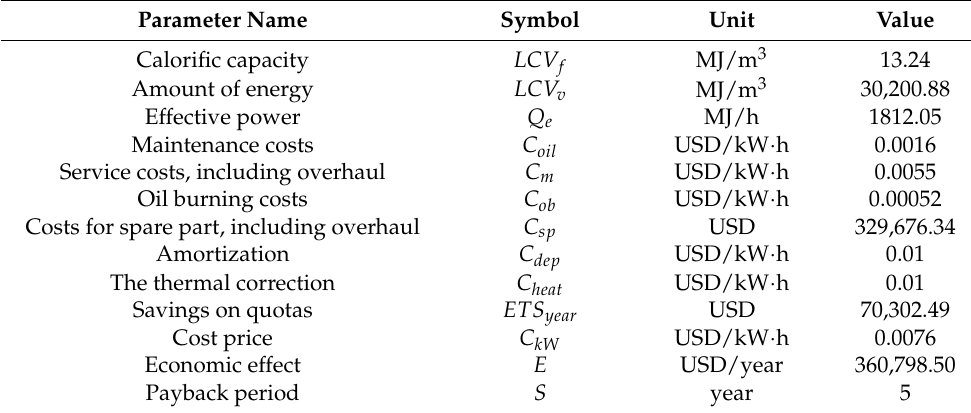
Table 3. Calculation results.